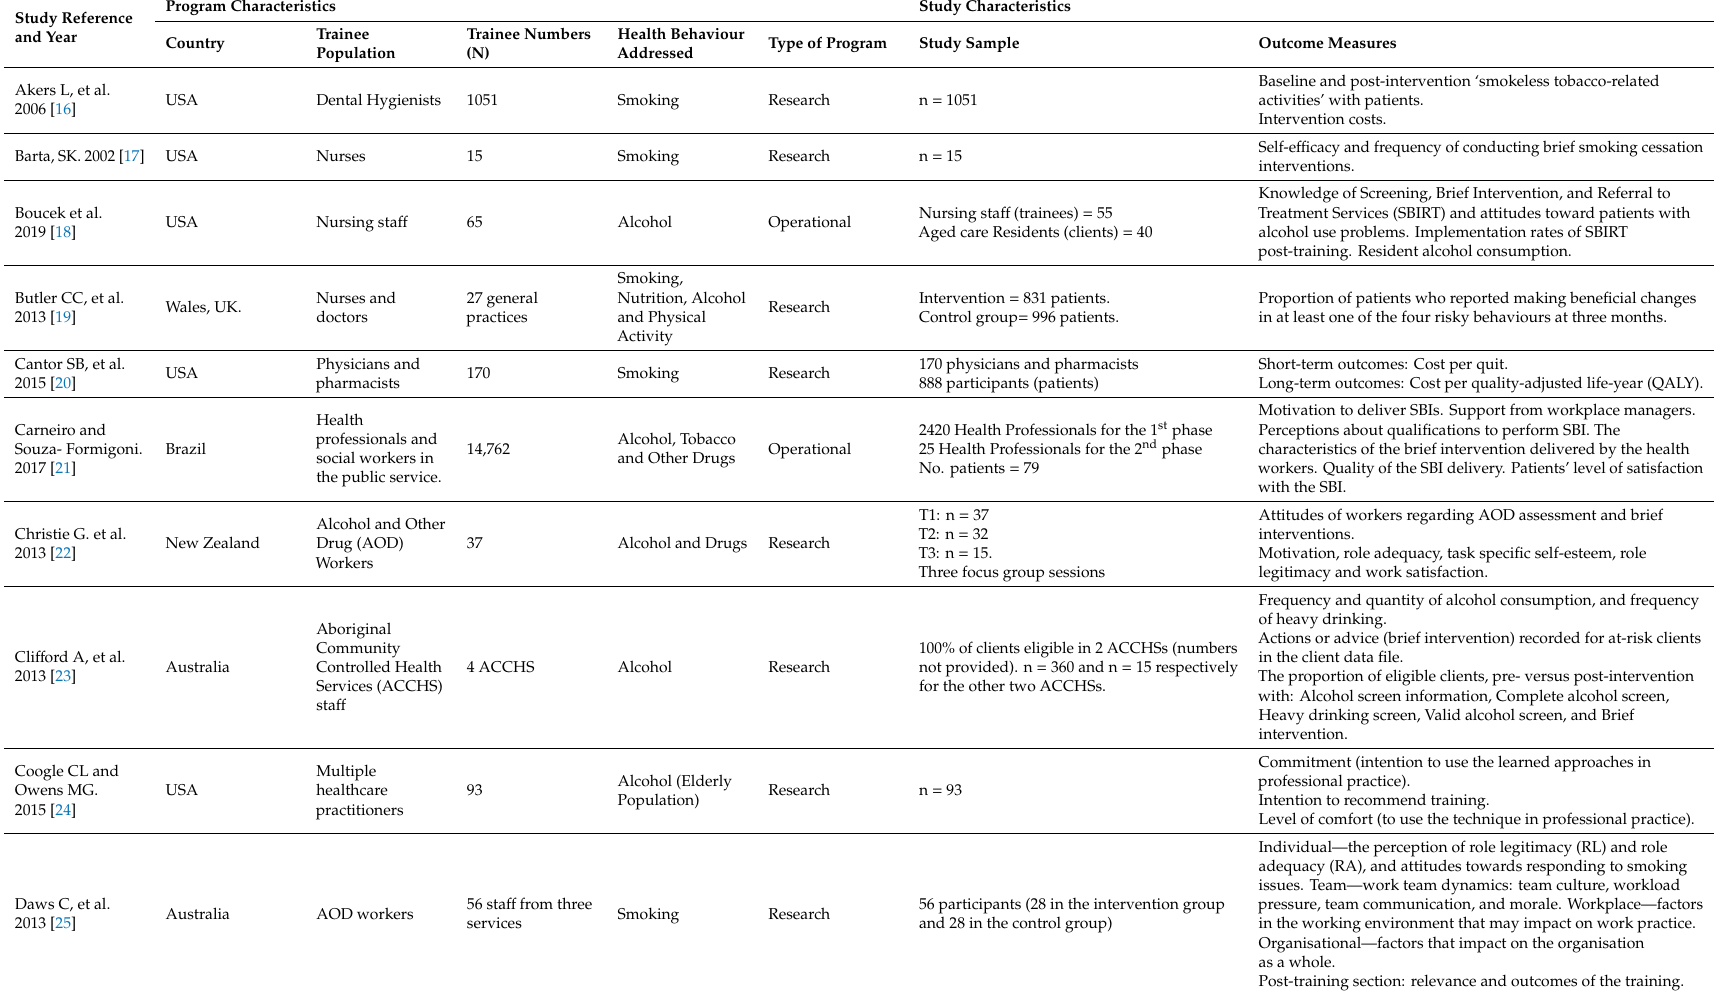
Table 2. Characteristics of included